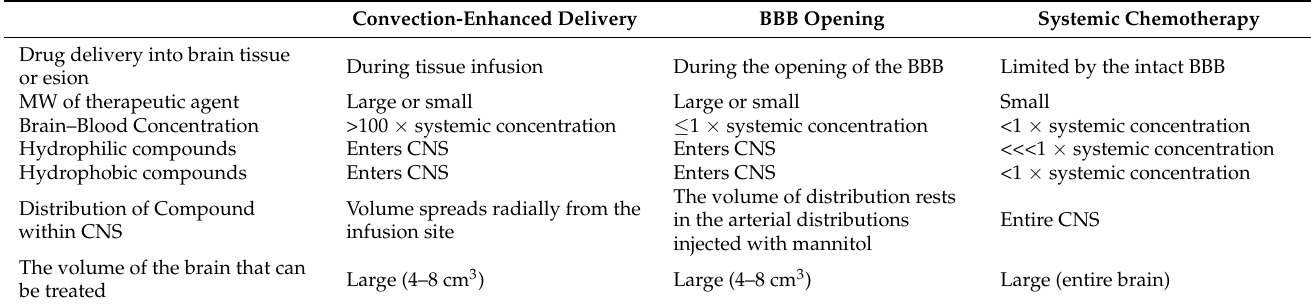
Table 2. Comparison of methods to deliver therapeutic agents to glioblastoma.